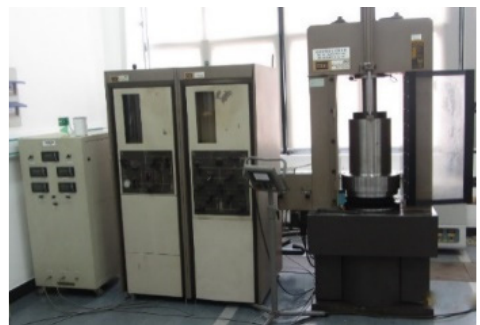
Figure 1. Standard test samples.